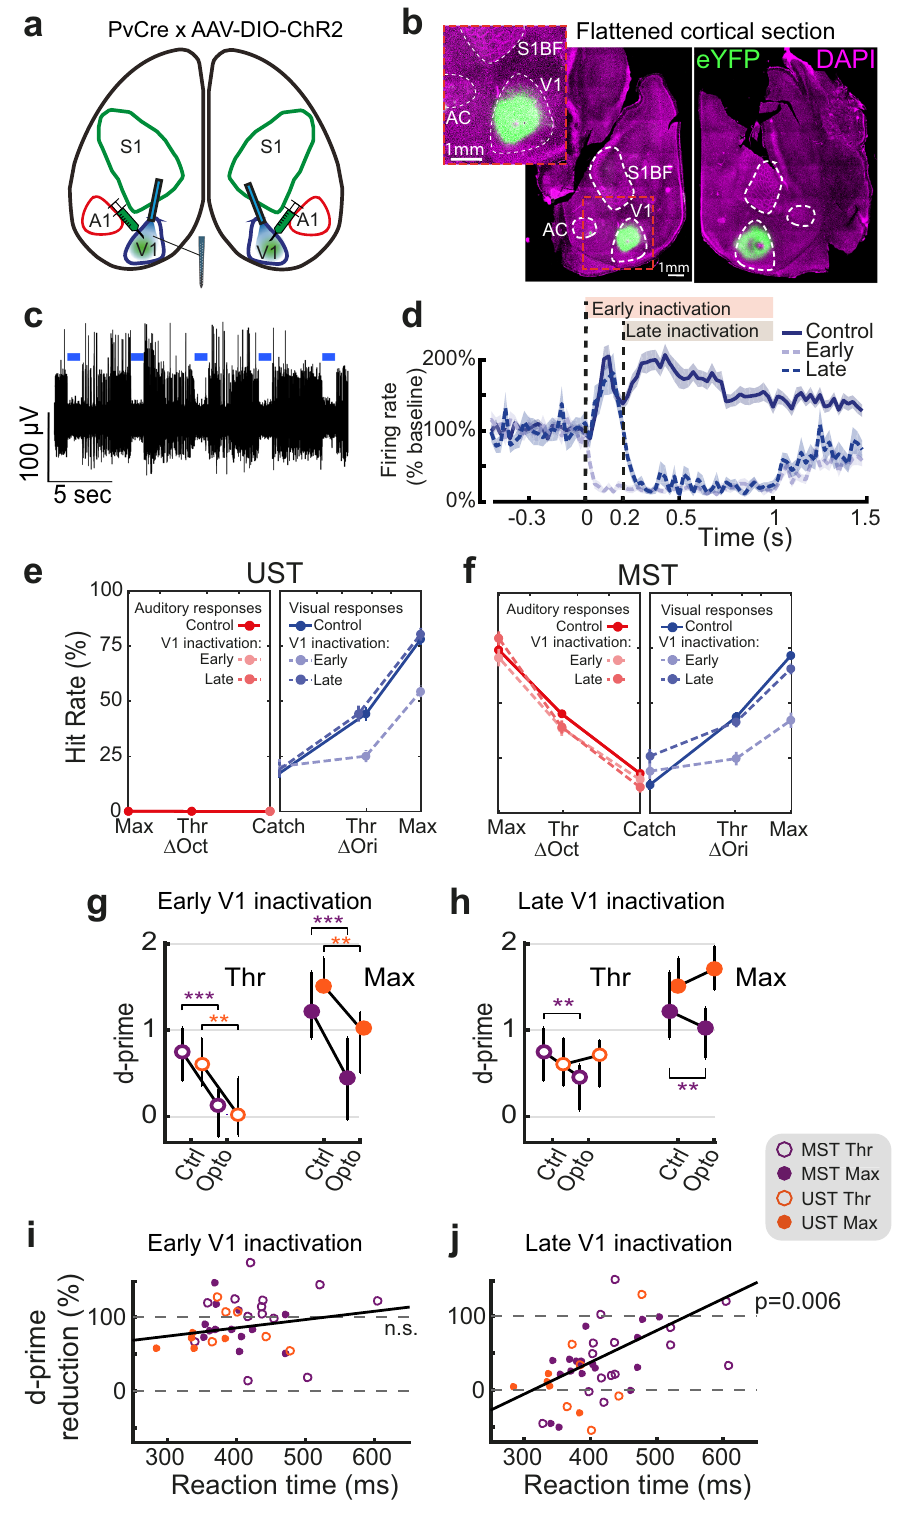
for both unisensory and multisensory contexts, late V1 silencing only affected such detection in MST mice (Fig. 6d, Supplementary Fig. 8e). As in Task A, we observed that the effect of